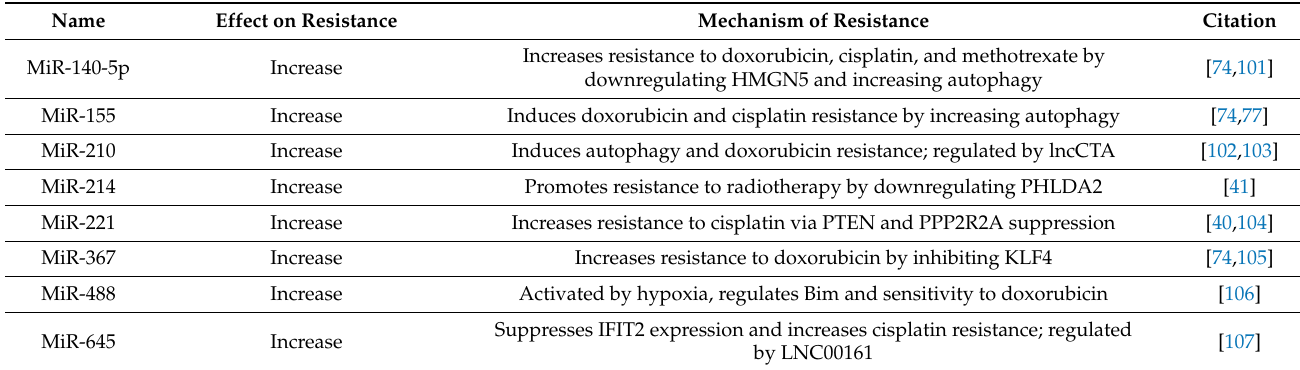
Table 2. MiRNA that are implicated in osteosarcoma therapy